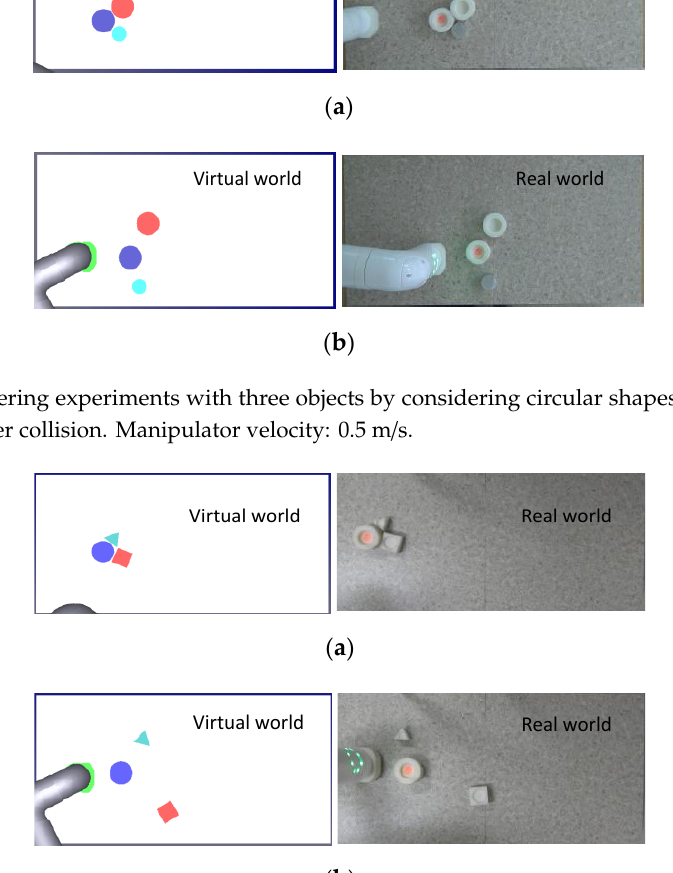
Figure 14. Scattering experiments for singulation of three objects by considering general shapes: ( a ) before collision; ( b ) after collision. Manipulator velocity: 0.4 m/s.